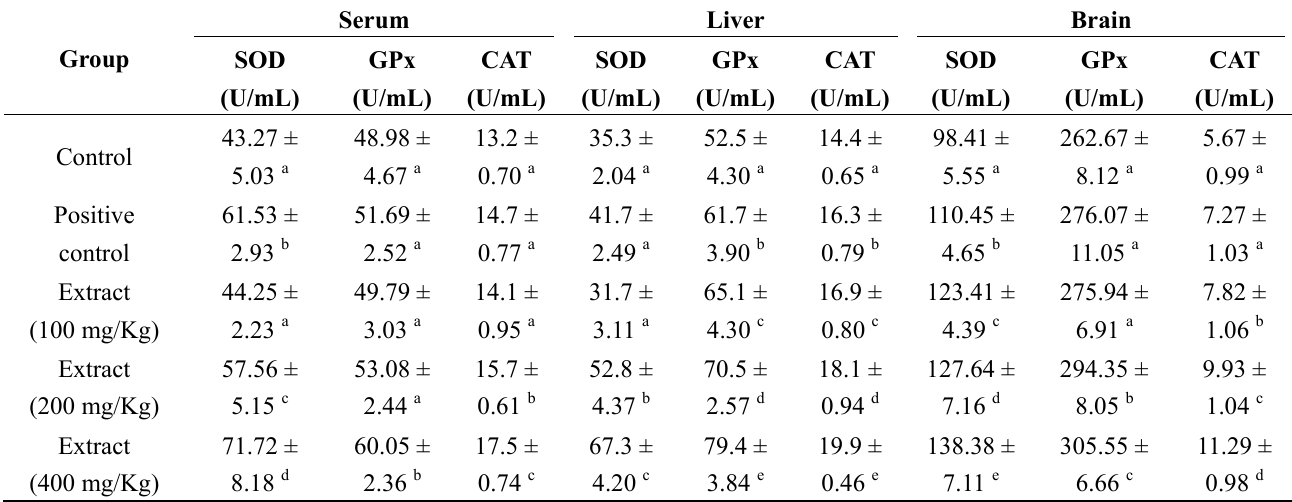
Table 3. Effects of Ganoderma lucidum grown on germinated brown rice (GLBR) on the activities of SOD (U/mg protein), GPx (U/mg protein) and CAT (U/mg protein) in serums, livers and brains of mice.